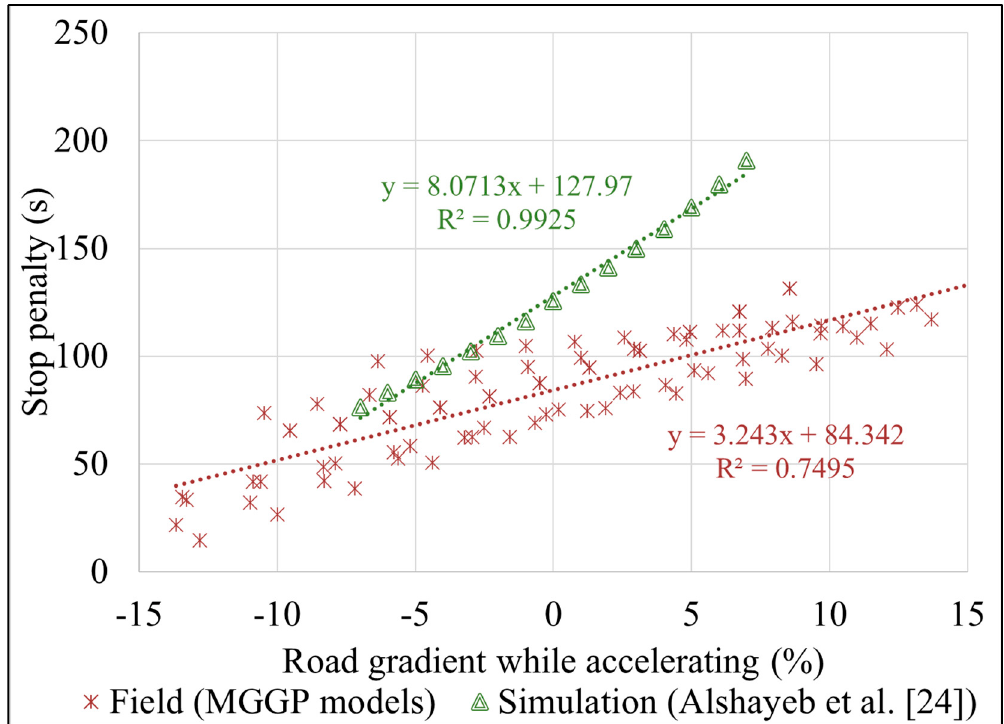
Figure 12. Stop penalty vs. road gradient from the field and simulation [24].